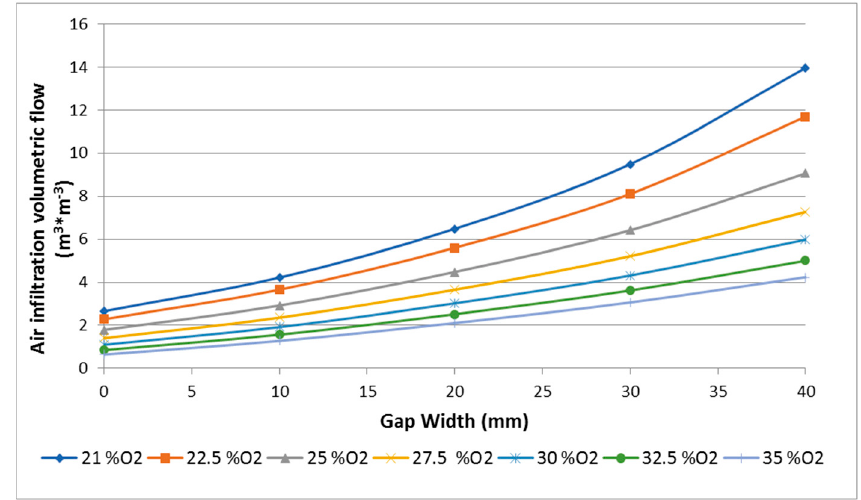
Figure 7. Dependence of calculated specific air infiltration volumetric flow (m 3 per m − 3 of combusted natural gas) on gap width.